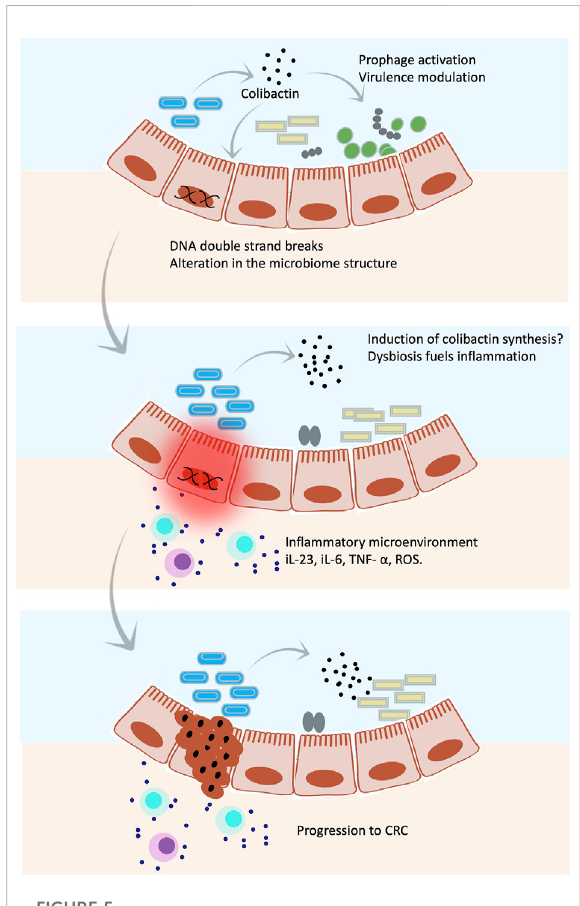
FIGURE 5 Colibactin hits targets in both eukaryotic and prokaryotic cells. Illustrations show an overall mechanism by which colibactin mediates host – microbe interaction. Colibactin shapes the gut microbial community by selective killing of some species through induction of prophages and/or stimulation of the virulence factor expression. Meanwhile, colibactin induces double strand breaks in host DNA. The altered microbial community together with the genetic abnormalities caused by colibactin triggers an in fl ammatory microenvironment, which might induce synthesis of more colibactin, leading to even greater damage that might result in